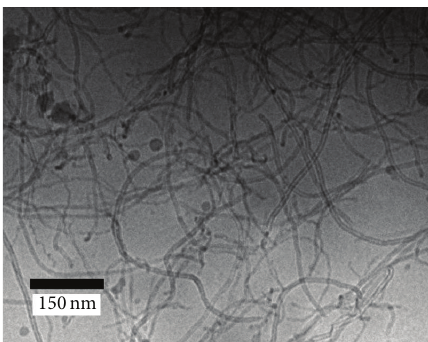
Figure 2: TEM image of CNTs dispersed in an aqueous solution